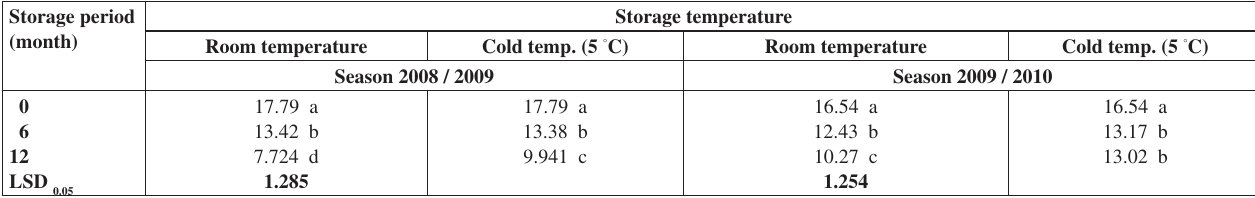
Table 16: Effect of the interaction between storage temperature and storage period on catalase activity of onion seeds during seasons of